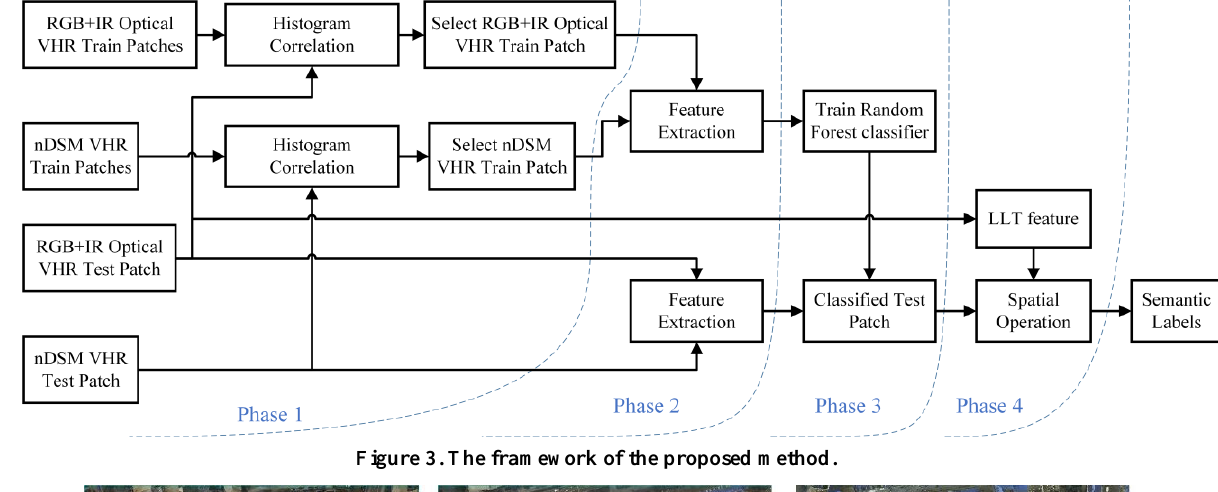
Figure 3. The framework of the proposed method.